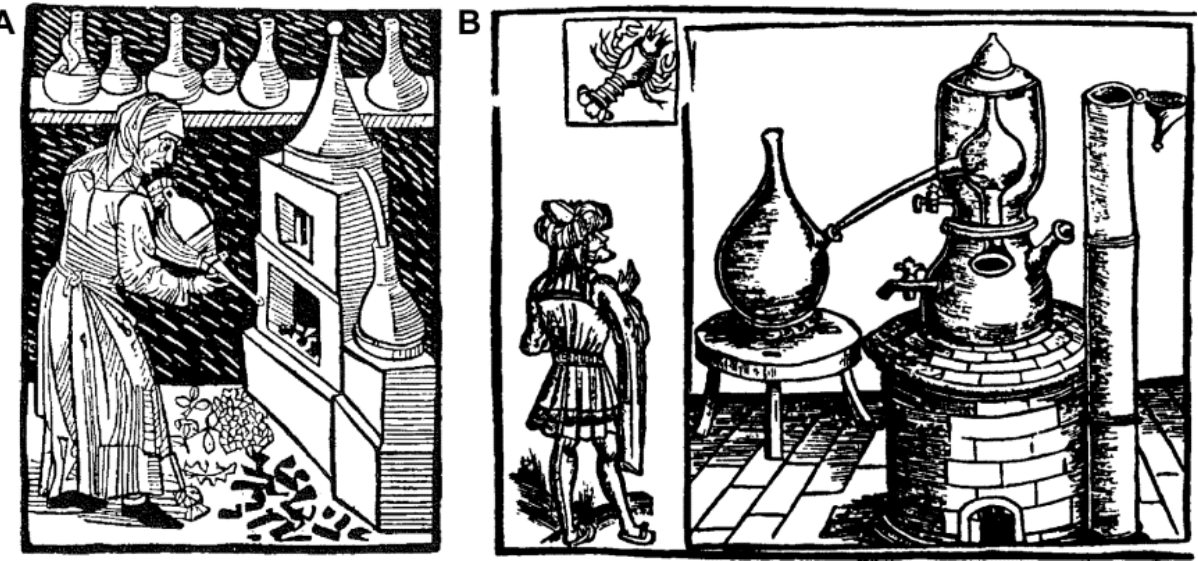
Figure 5. Illustrations of the Rosenhut from Michael Puff von Schrick’s Hienach volget ein nüczliche materi von manigerley ausgepranten wasser, 1478 (A) and the Moor’s head from Hieronymus Brunschwyck’s Liber de arte distillandi de Compositis , 1512